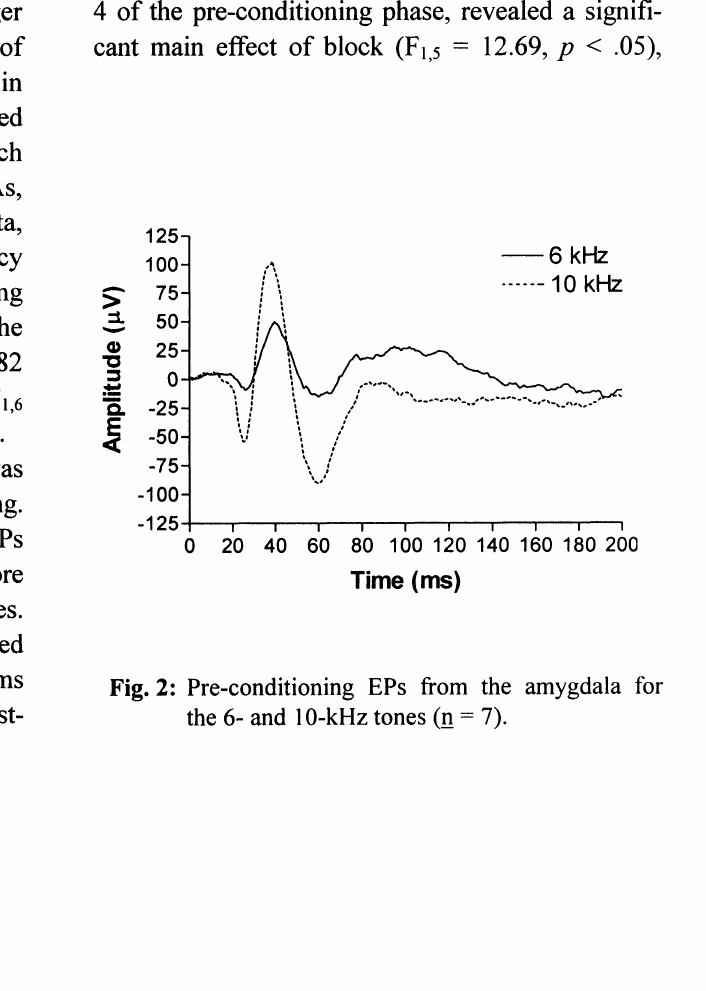
Fig. 2" Pre-conditioning EPs from the amygdala for the 6- and 10-kHz tones (_n-